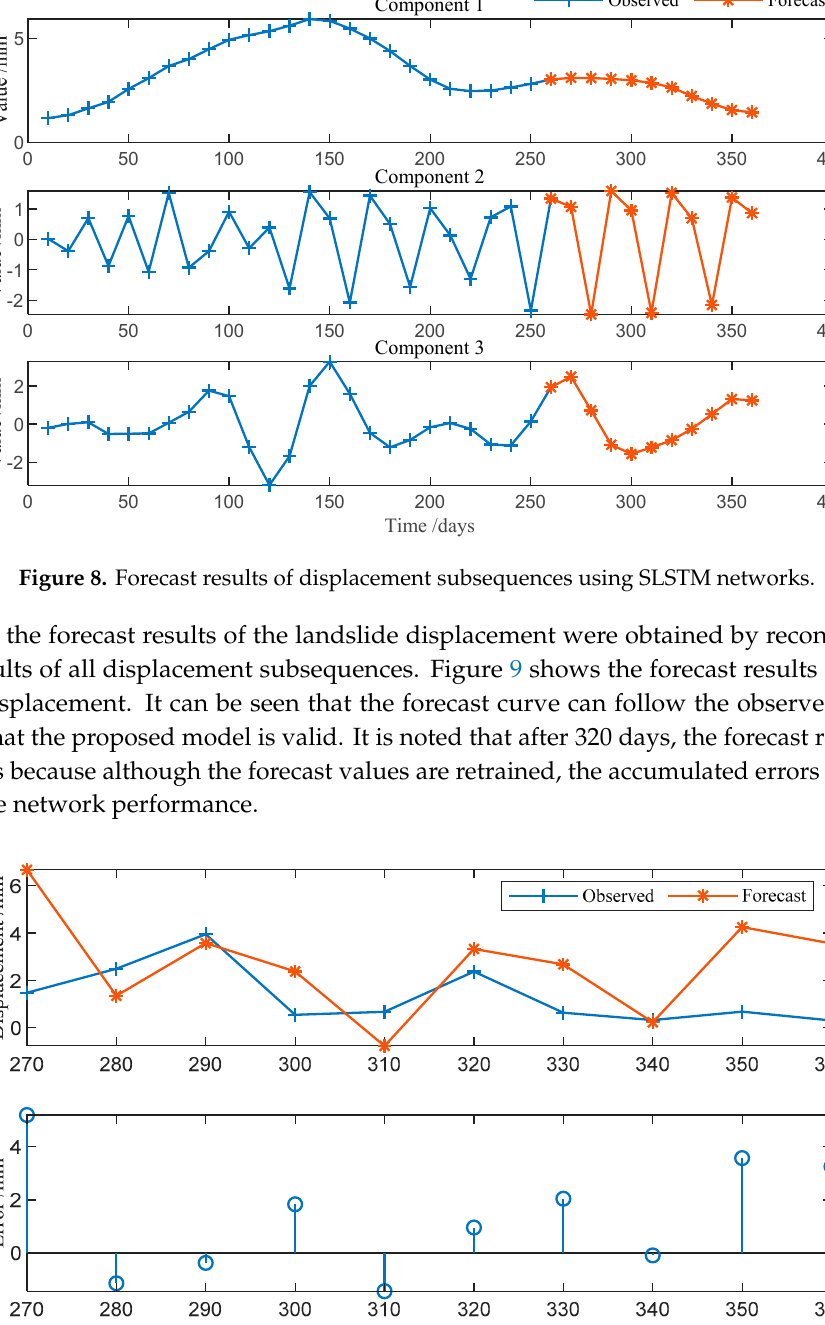
Figure 10. Forecast results of landslide displacement using three forecasting models: VMD-SLSTM, empirical mode decomposition (EMD)-SLSTM, and LSTM. Table 1 reports the mean absolute error (MAE) and root mean square error (RMSE) of the forecast results using the three forecasting models. It can be seen that the MAE of the VMD-SLSTM network is 1.99 mm, lower than the 3.99 mm of the LSTM network and 2.25 mm of the EMD-LSTM network. On the other hand, the RMSE of the EMD-SLSTM network is 2.50 mm, lower than the 4.15